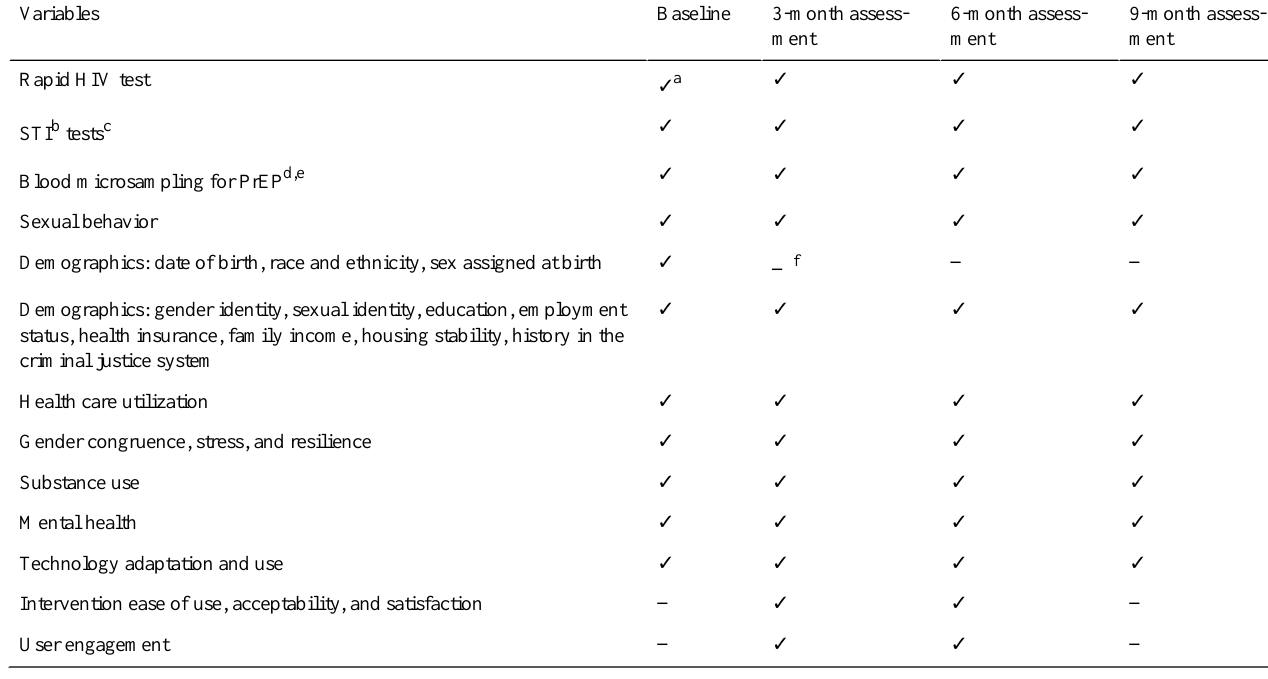
Table 2. Study outcome variables and data collection